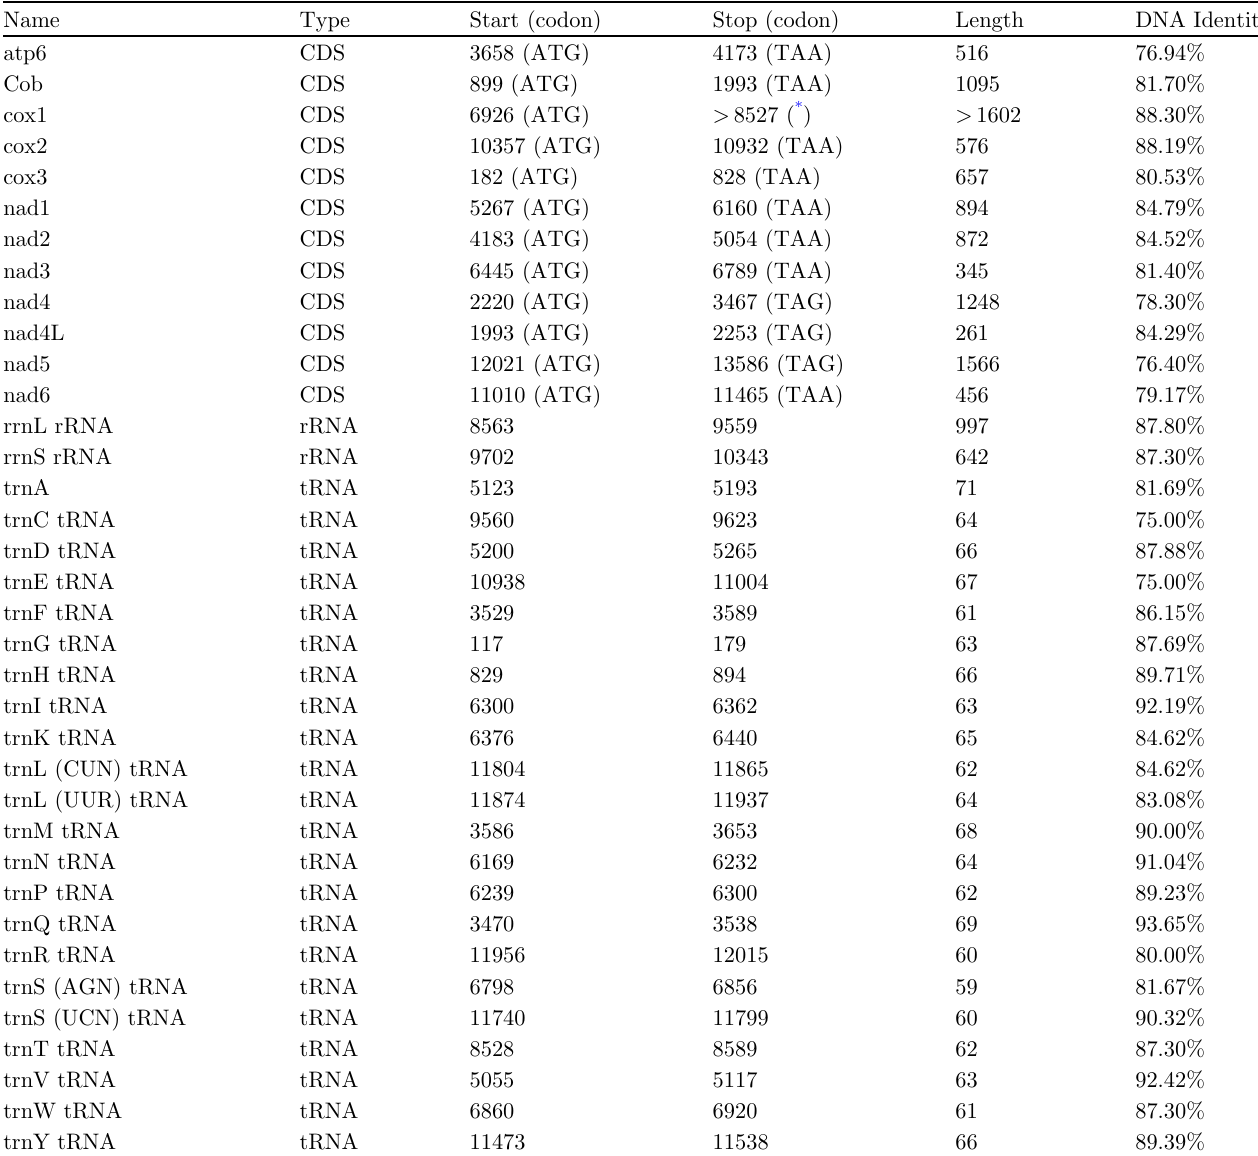
Table 7. Results following analysis of the CDS, rRNA and tRNA regions (36 in total) with the speci fi c associated identities between the two mitochondrial